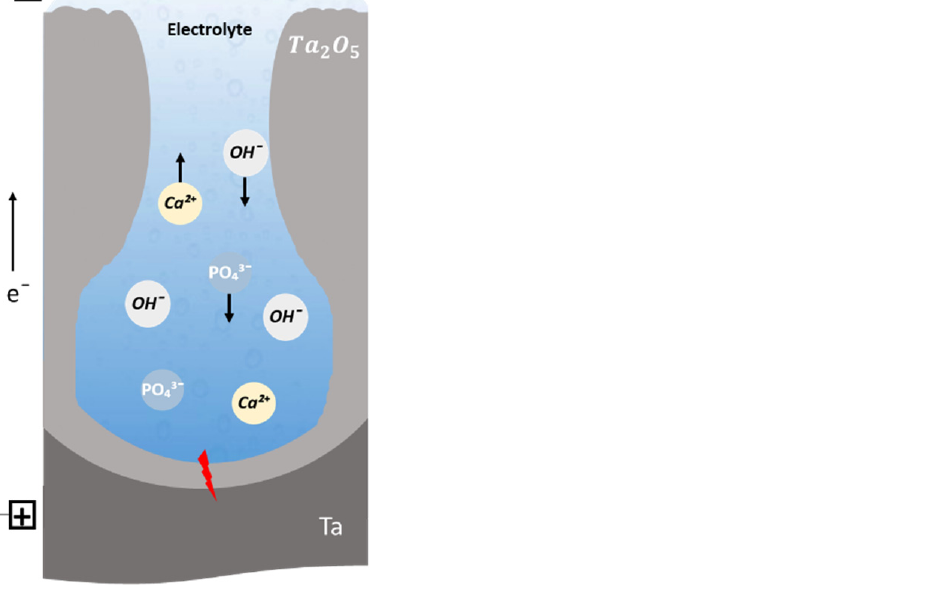
Figure 2. Schematic illustration of transport phenomena that takes place during the MAO process. Using the analysis of the voltage/current density—time curve, the MAO process, car- ried out in DC mode onto a Ta surface, can be divided into three distinct stages as displayed in Figure 3A,B [46,58,61,62]. In the first seconds of a galvanostatic mode (constant current) (Figure 3A), the voltage sharply increases in a short time, which is defined as the first stage of the MAO process. Like traditional anodization, a compact oxide coating is formed in this stage. Throughout the anodic coating growth, the electric field strength for a given current density remains constant during the anodic growth, and the ionic current is two or three orders of magnitude larger than the electronic component. Furthermore, the voltage increases with the increase in the anodic coating thickness to maintain the electric field strength constant [45,58,61]. In this stage, galvanoluminescence is not observed. During the electrolytic oxidation, electrons are injected into the conduction band of the anodic layer and are accelerated by the electric field producing avalanches using an ionization mecha- nism [61]. When the electronic current avalanche reaches a critical value (the breakdown potential of the oxide layer), dielectric breakdown occurs, which is reflected by an apparent deflection from the linearity of the V-t curve and the appearance of small sparks. Hence, the uniform coating thickening is terminated and starts a so-called breakdown voltage (second stage) [45,58,61] that activates and induces a fast increase in galvanoluminescence inten- sity [61]. The breakdown is triggered by local heating effects caused by highly localized processes taking place at macro and micro-defects in the oxide (electrolyte-filled fissures, micropores, flaws) [46,58]. The voltage keeps increasing continually, but the voltage–time slope decreases, and a large number of bright spots (micro-discharges) appear over the whole surface. The slope decreases as a consequence of the relatively low voltage required to maintain the same total current density, because of the dependency of the electron’s current density on the anodic coating thickness. Further, the third stage is reached when the voltage is relatively constant, with a voltage–time slope near zero, since the total current density is practically independent of the anodic layer thickness, as the fraction of electronic current density in the total current density becomes dominant